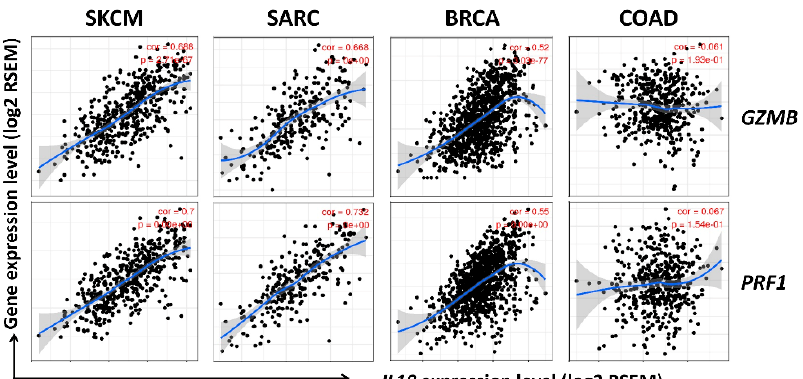
Figure 6. Correlation of IL18 expression with granzyme B ( GZMB ) and perforin ( PRF1 ) in SKCM. Correlations of IL18 expression with the expression of two cytolytic molecule gene markers ( GZMB and PRF1 ) were examined using the TIMER website. A strong positive correlation between IL18 expression and both cytolytic molecule genes were seen in SKCM, BRCA, and SARC. IL18 expression was not correlated with either gene in COAD.